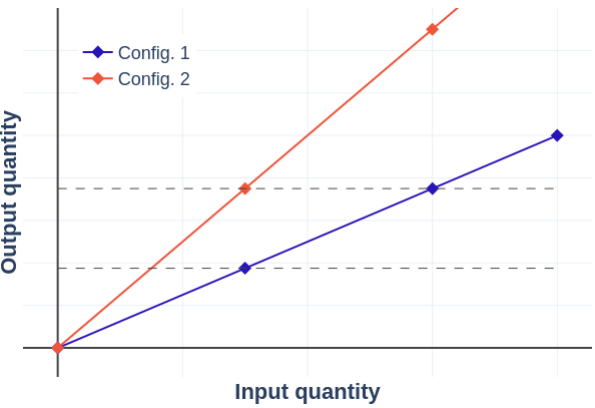
Figure 1. Output characteristics of a system with scaled